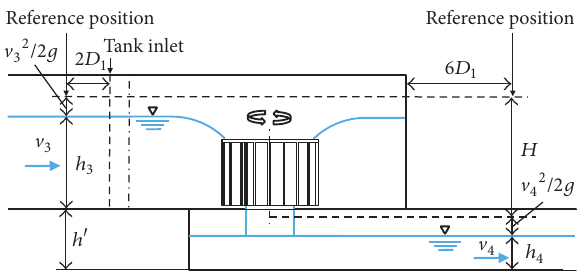
Figure 5: Calculating